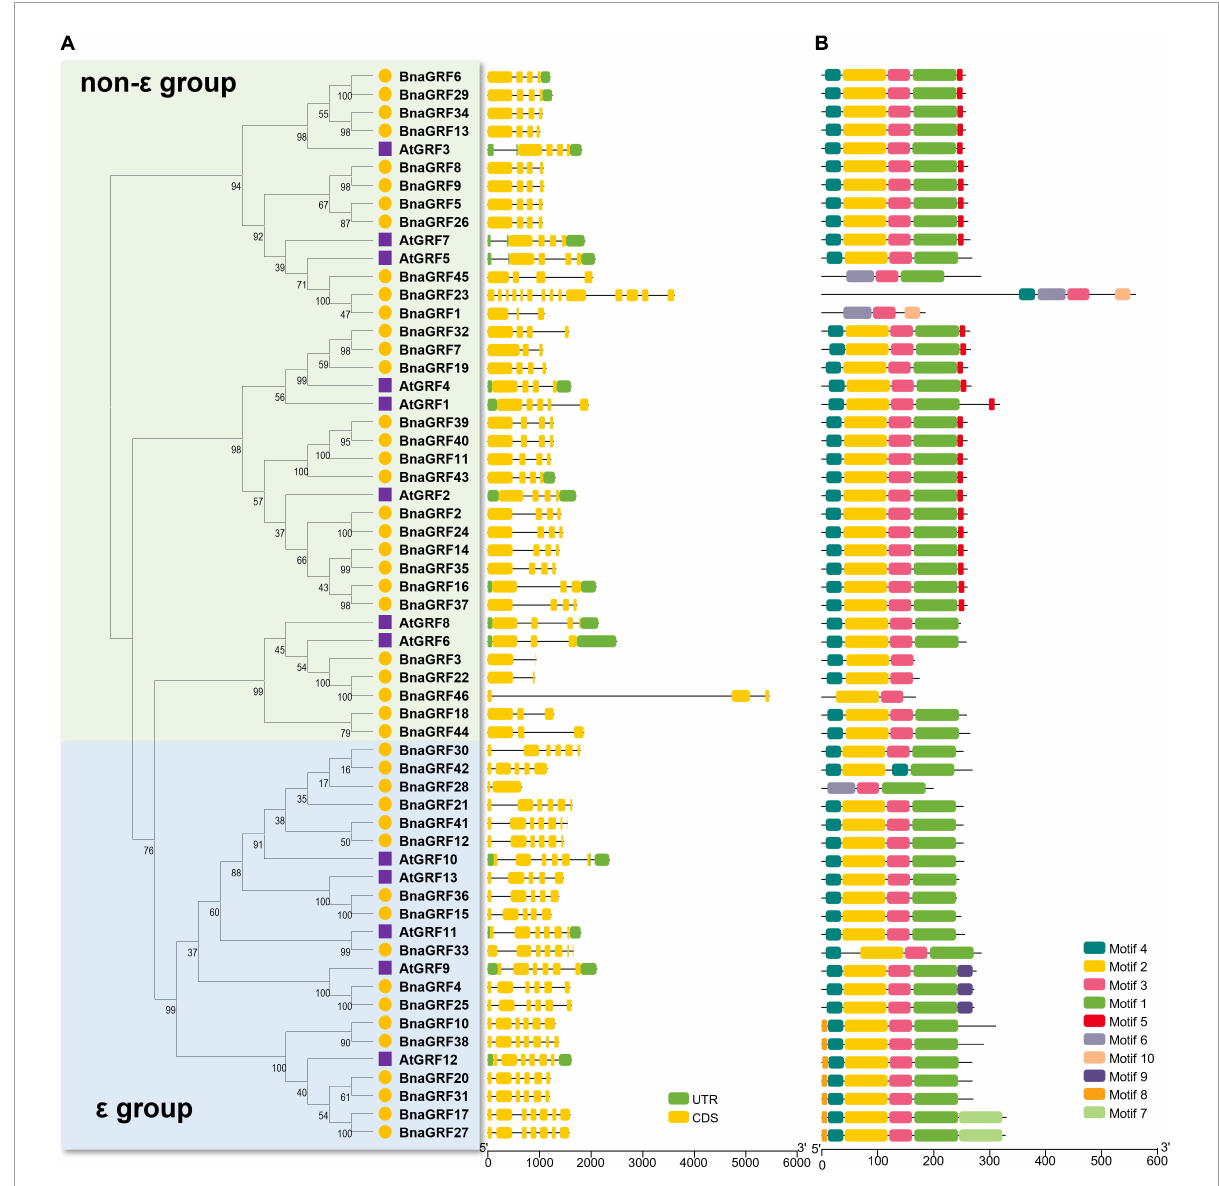
FIGURE3 Gene structure and motif analysis of 14-3-3 family genes in B. napus and Arabidopsis. (A) Gene structure of BnaGRFs and AtGRFs . Green color indicates the untranslated regions (UTRs); yellow color represents the coding sequence (CDS) or exons; and black horizontal lines indicate the introns. (B) Conserved domain structures identified in BnaGRFs and AtGRFs . Boxes with different colors indicate different